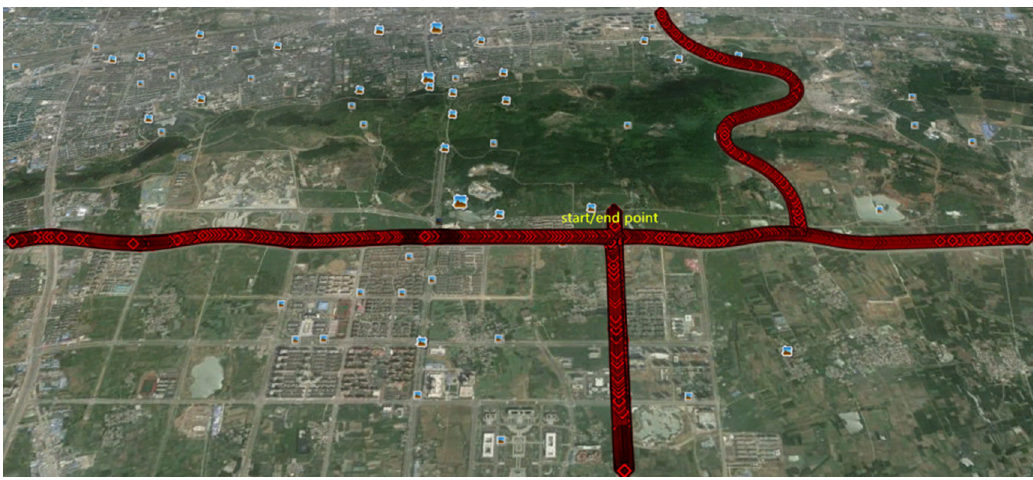
Figure 1. The vehicle’s route.